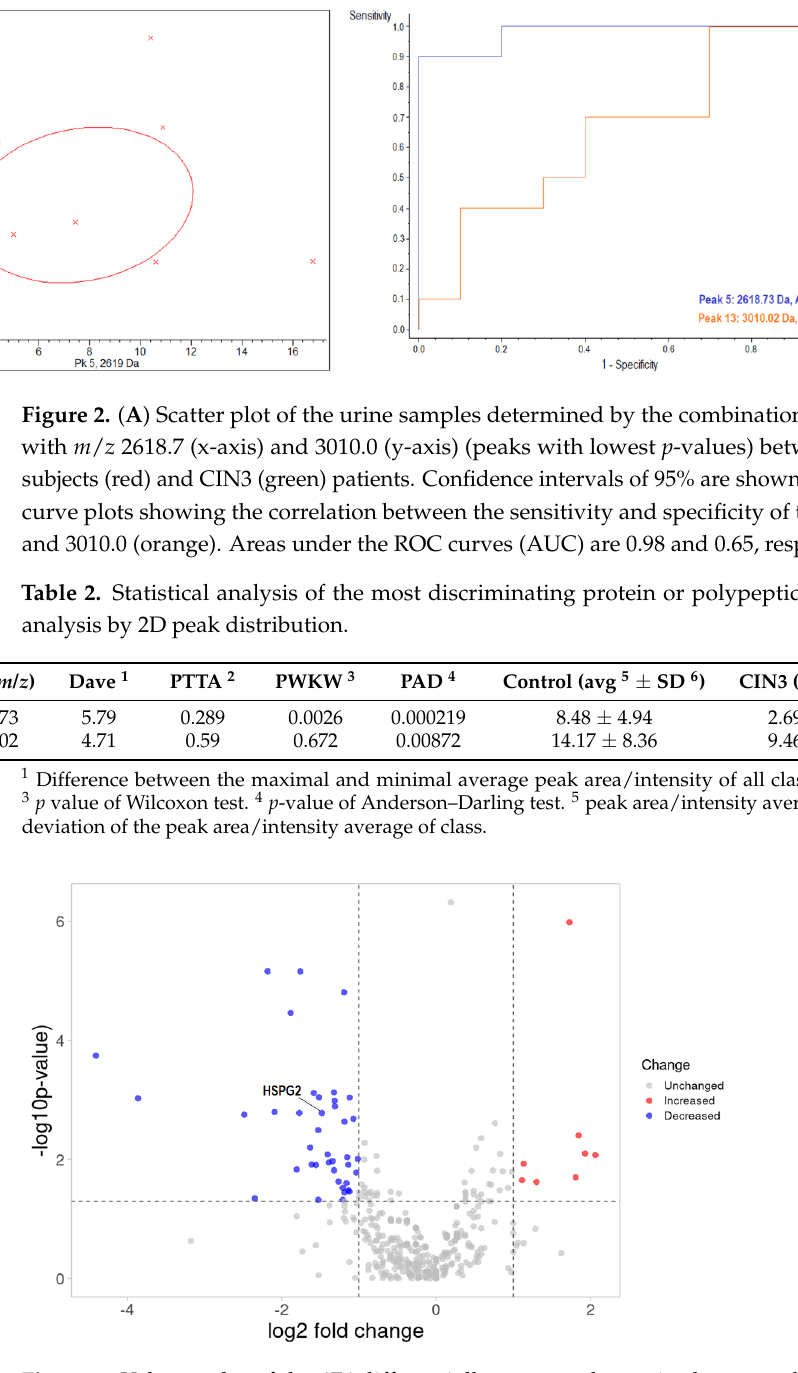
Figure 3. Volcano plot of the 476 differentially expressed proteins between the CIN3 and healthy controls. The 48 proteins that were significantly changed ( p -value less than 0.05 and log 2 -fold change ≥1.0 or ≤− 1.0), i.e., 8 up-regulated (red) and 40 down-regulated (blue) proteins. Volcano plots were generated with the VolcaNoseR online web tool with R/Shiny (https://huygens.science. uva.nl/VolcaNoseR, accessed on 16 November